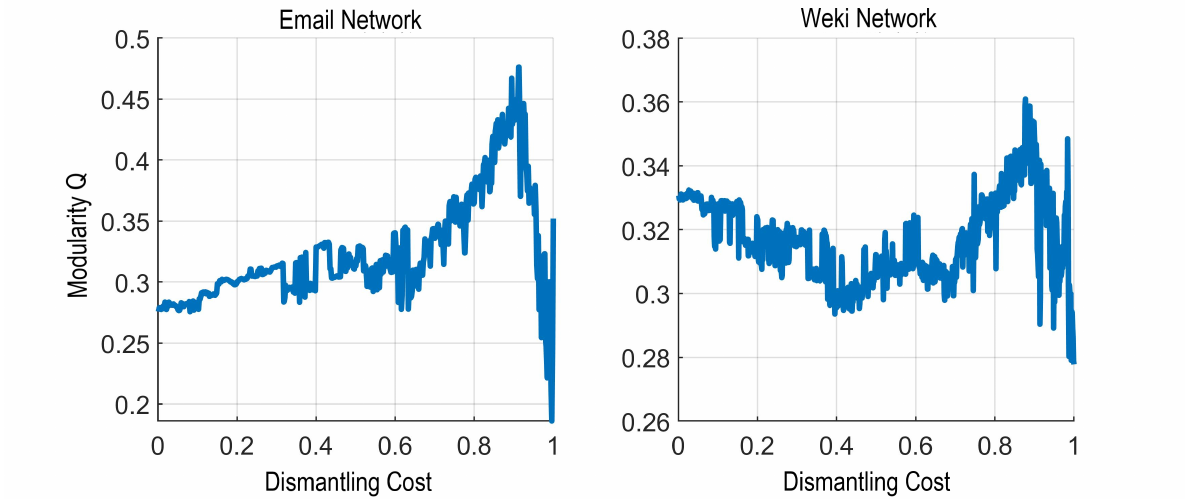
Figure 8. Curve graph of disassembly cost and module degree Q of real